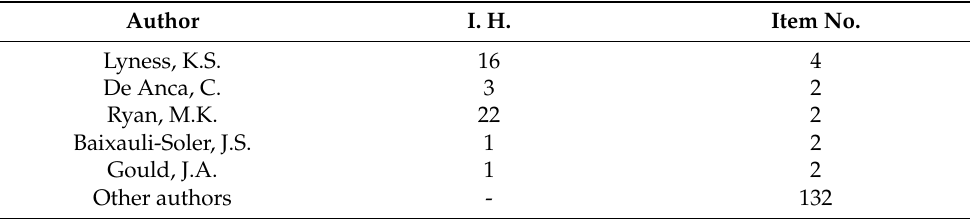
Table 2. Number of articles by author and author’s index